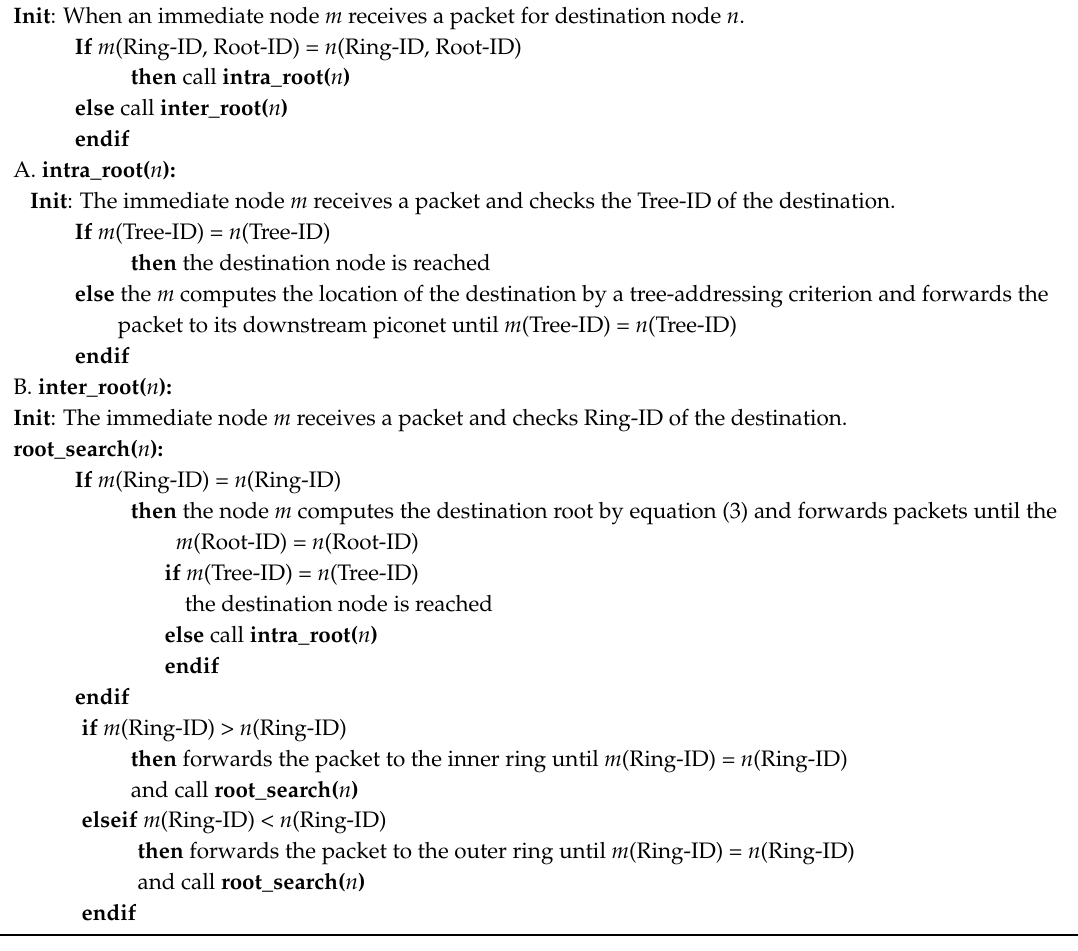
Algorithm 2 The pseudo-code of the scatternet self-routing